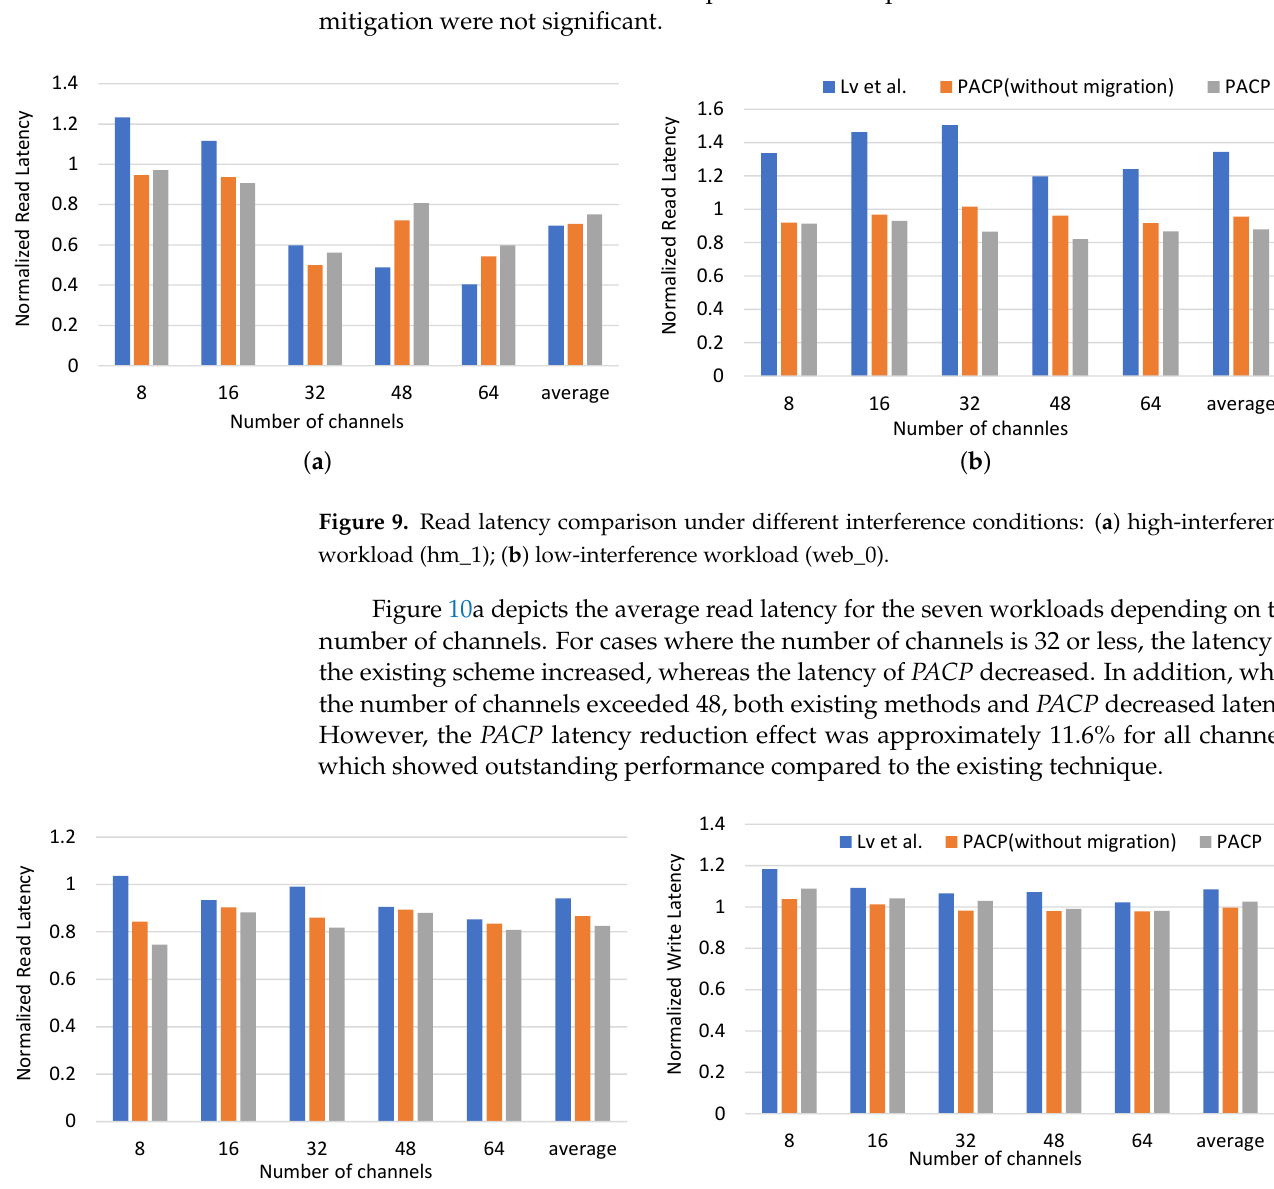
Fig. 9. Comparison of write latency according to the number of channels Figure 10. Average latency comparison for all workloads: ( a ) read; ( b ) Fig. 8. Read Latency latency comparison under different interference condition (a) high- interference workload (hm_1); (b) low-interference workload (web_0); and workload (b) Conclusion interference workload (c) overall